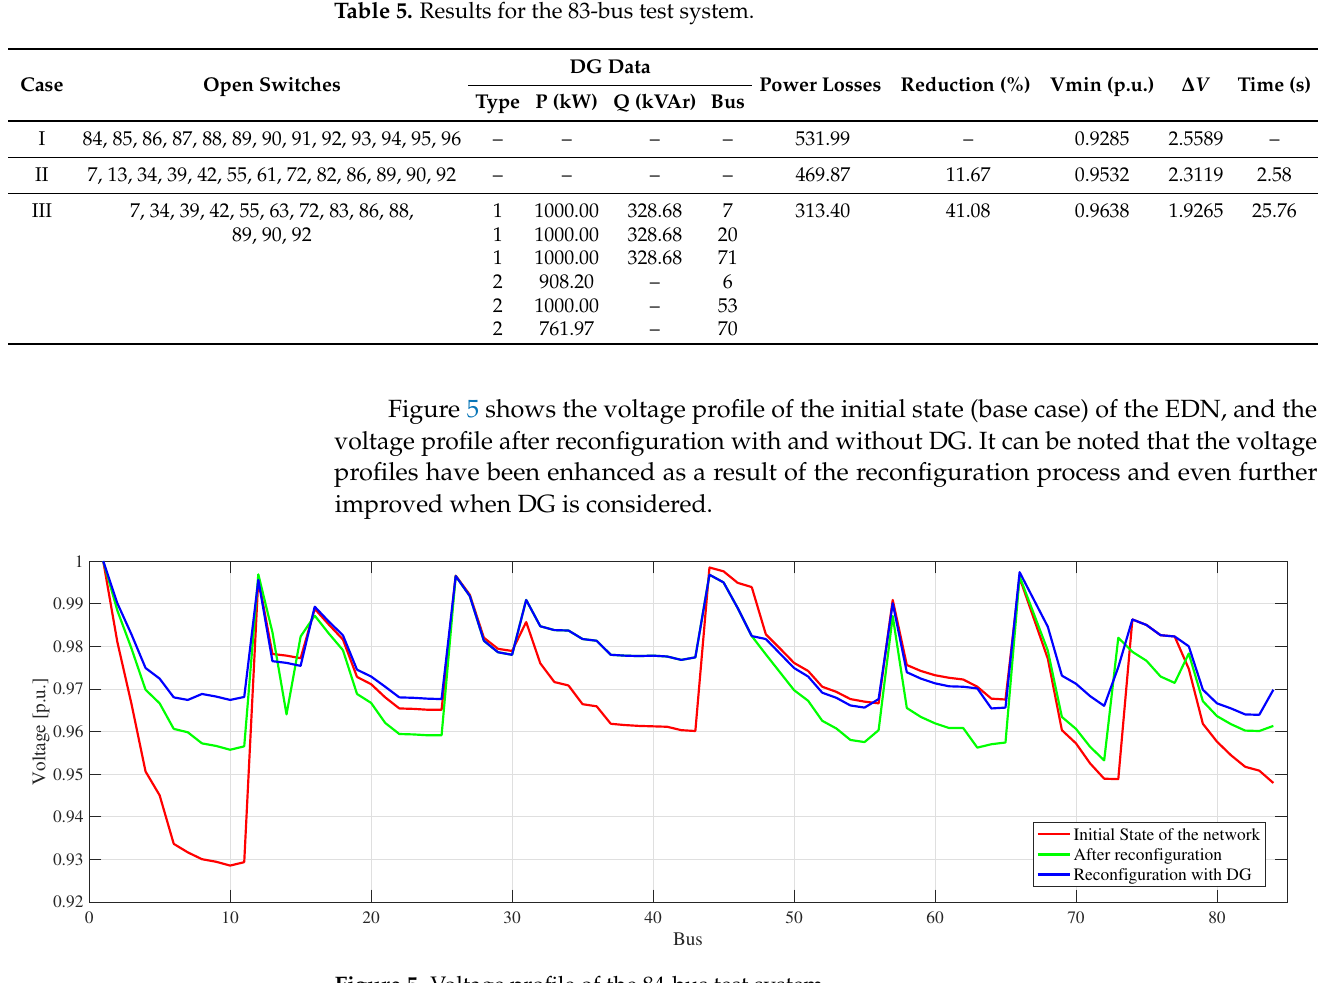
Figure 5. Voltage profile of the 84-bus test